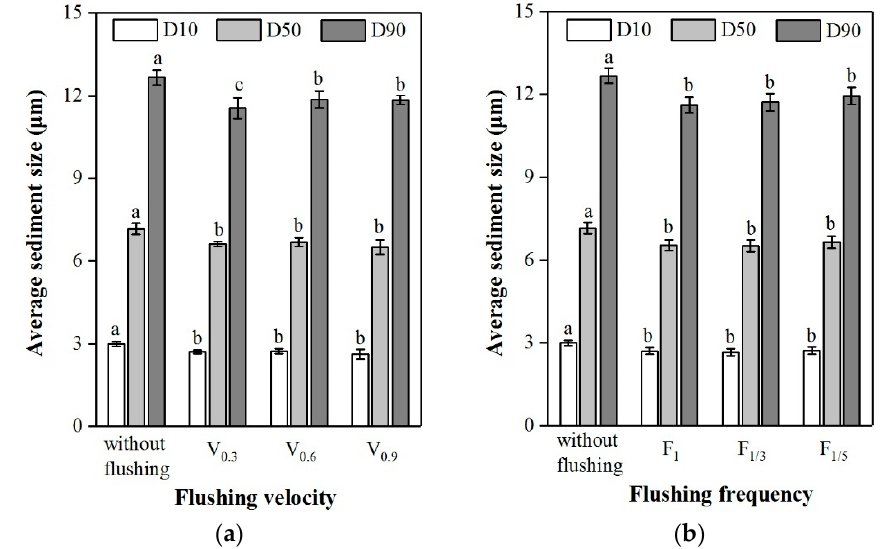
Figure 6. Average and standard errors of D10, D50, and D90 at different flushing ( a ) velocities and ( b ) frequencies.